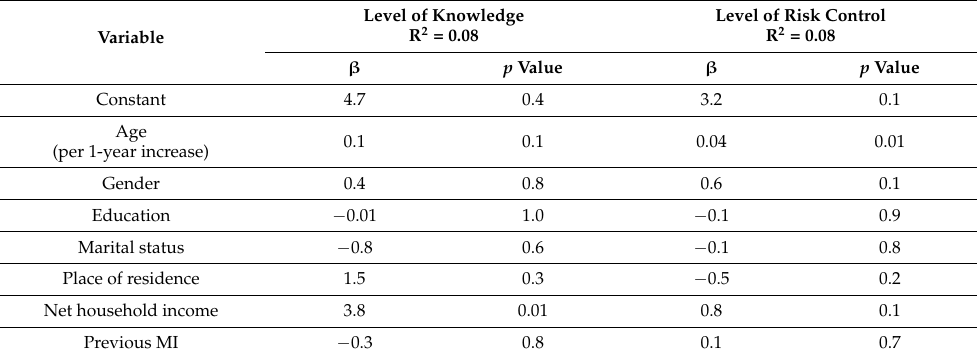
Table 5. Impact of factors other than a history of PCI or CABG on the level of knowledge and the level of coronary artery disease risk control—multiple regression